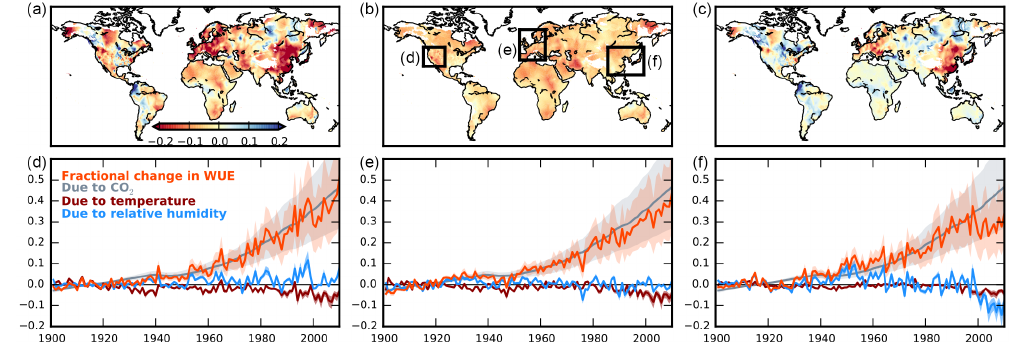
Figure 7. Changes in WUE arising from climate variables. Spatial patterns of the fractional changes in WUE arising from changes in (a) climate, i.e. both temperature and relative humidity (RH) together, (b) temperature alone, and (c) RH alone, between 1901–1930 and 2001–2010. Time-series are as in Fig. 5 for (d) western North America, (e) western Europe and (f) East Asia, which show the large regional and temporal variations in these climate-driven changes in